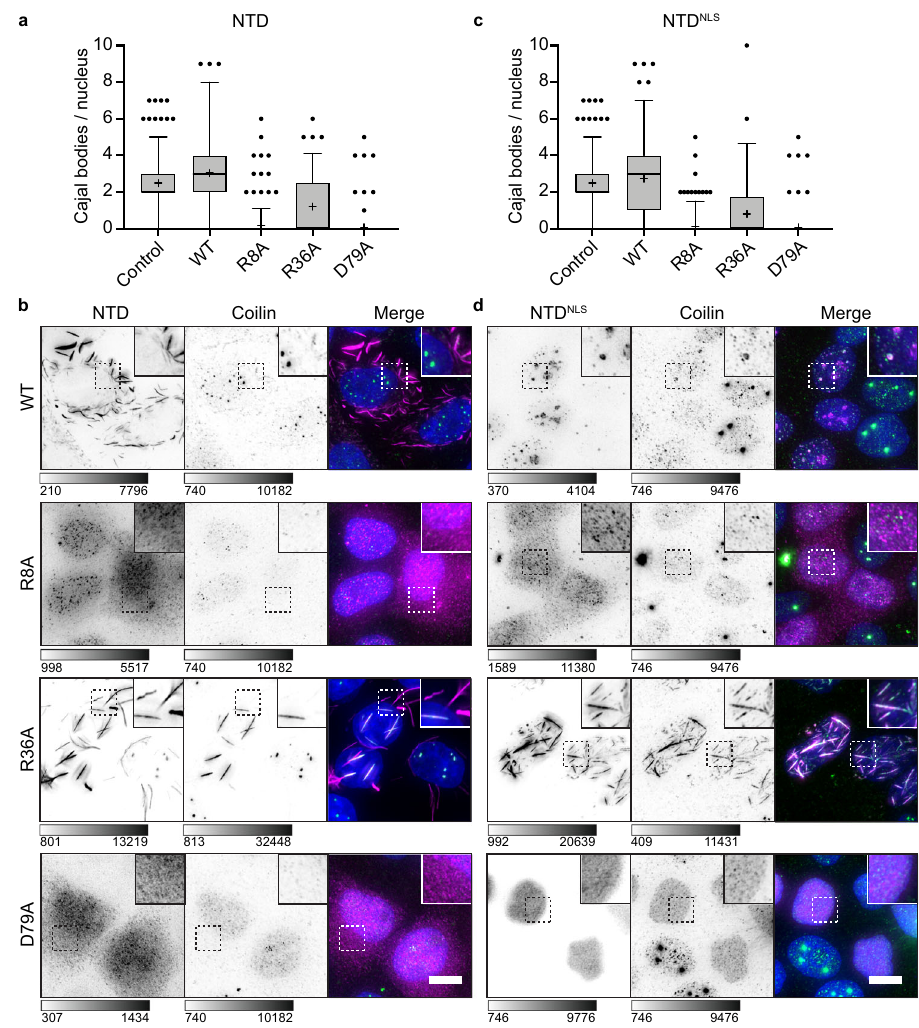
Fig. 6 | Coilin NTD mutants exert dominant negative effects on endogenous coilin and Cajal bodies. Wild-type and mutant myc-tagged coilin NTD constructs expressed in the cytoplasm (NTD, a , b ) and nucleus (NTD NLS , c , d ) of HeLa cells. ( a , c ) Cells were immunostained for NTD-myc and endogenous coilin and Cajal bodies were quanti fi ed. Measures of center include the median (horizontal line) and mean (cross). The box is drawn from the 25th to the 75th percentile. The